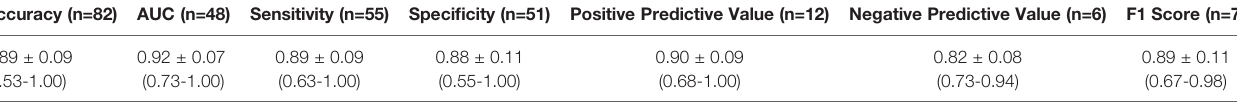
TABLE 1 | Mean (± standard deviation) aggregate performance metrics across